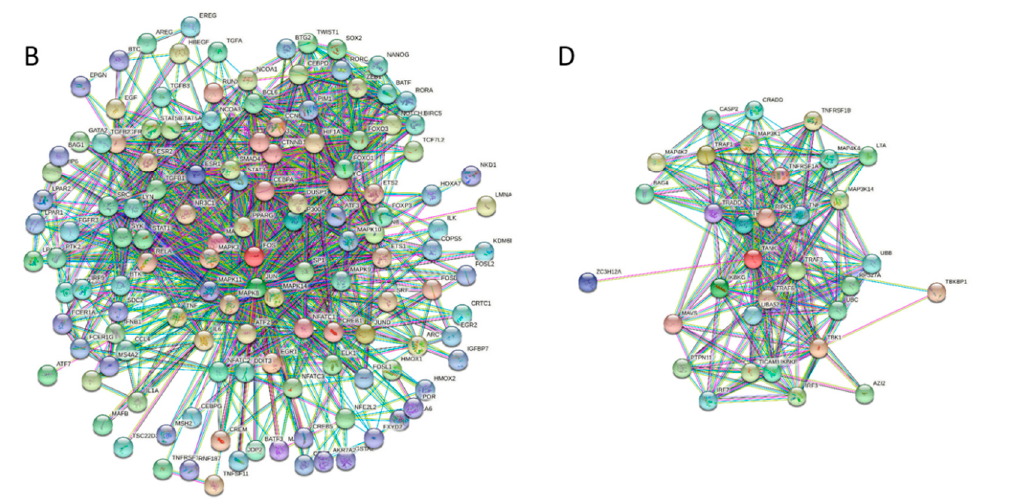
Figure 7. The PPI networks of human for IKK γ ( A ), c-FOS ( B ), Jun ( C ), and TANK ( D ) generated by STRING [98]. The IKK γ -centered PPI network includes 116 partners connected by 1209 interactions, indicating that each member of this network interacts with ~21 partners. c-FOS interacts with 131 proteins, each interacting with ~15 partners, thereby generating a network with 985 interactions. A total of 209 partners of Jun were linked to each other via 2076 interactions, being involved in ~20 interactions each. Finally, the TANK-centered PPI network included 52 partners connected by 320 interactions, indicating that each member of this network interacts with 12 partners.